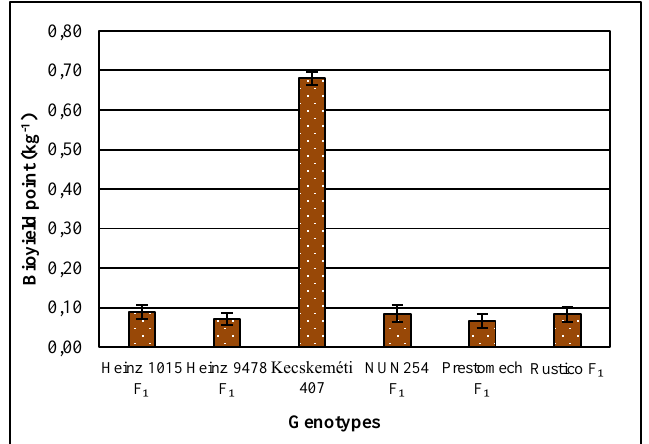
Figure 5. Bioyield point of different genotypes.